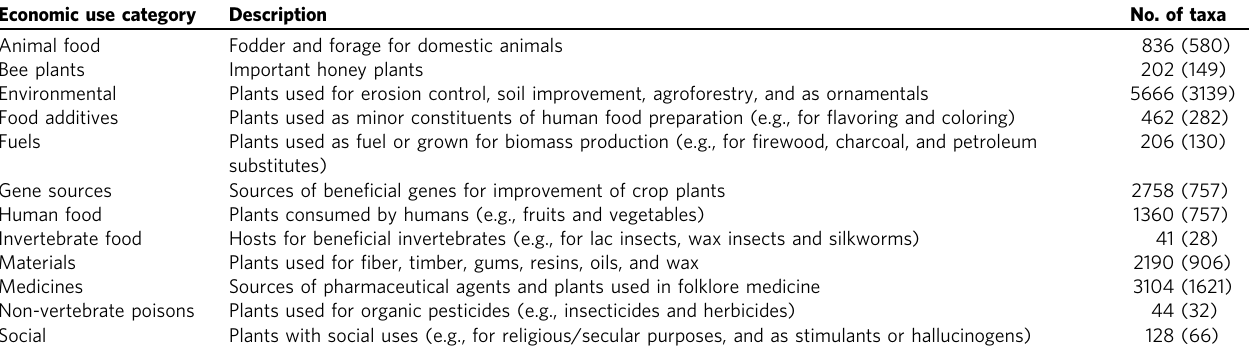
Table 1 The 12 categories of economic uses from the World Economic Plants database that were included in our analyses.